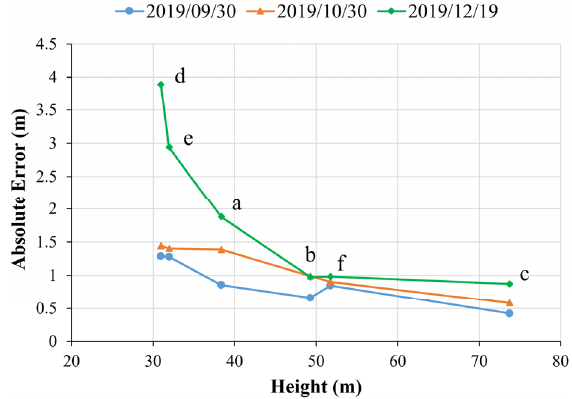
Figure 5 . The relationship between the sun altitude/iceberg height and the accuracy of results. The labels a-e correspond to the icebergs in Figure 1.